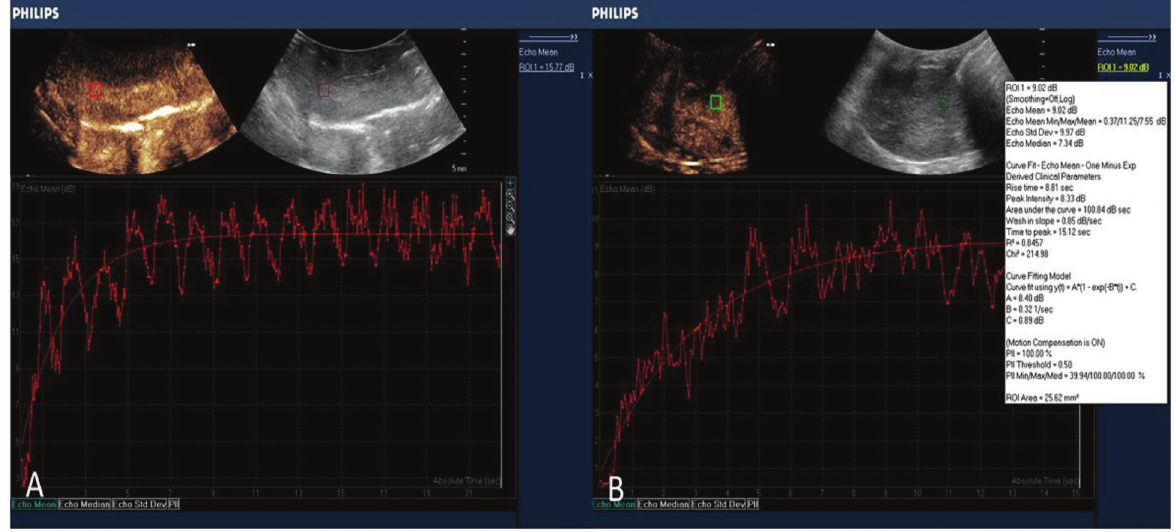
Figure 6. Hepatic perfusion time-intensity curves before blocking ( A ) and after reperfusion 120 min ( B